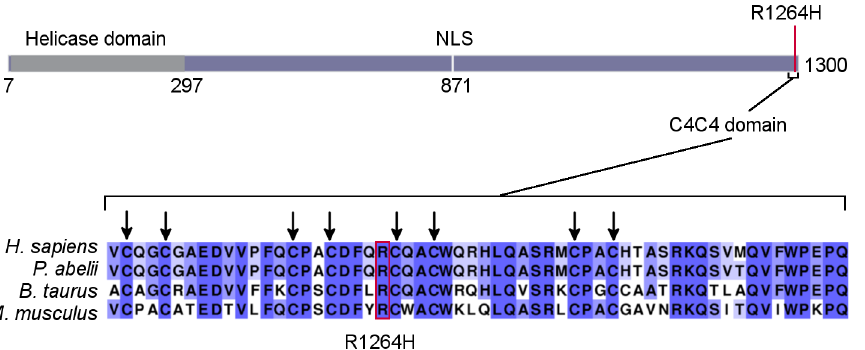
Figure 3. RTEL1 R1264H affects a putative conserved C4C4 domain. As displayed on the schematic (representing ENSP00000353332), the RTEL1 mutation is at the C-terminus of the protein, distal to the helicase domain. The affected amino acid is in a putative C4C4 domain. All eight key cysteines and R1264 are conserved in human, orangutan, cattle, and mouse sequences. Higher percent identity at a given amino acid position is indicated by a deeper purple